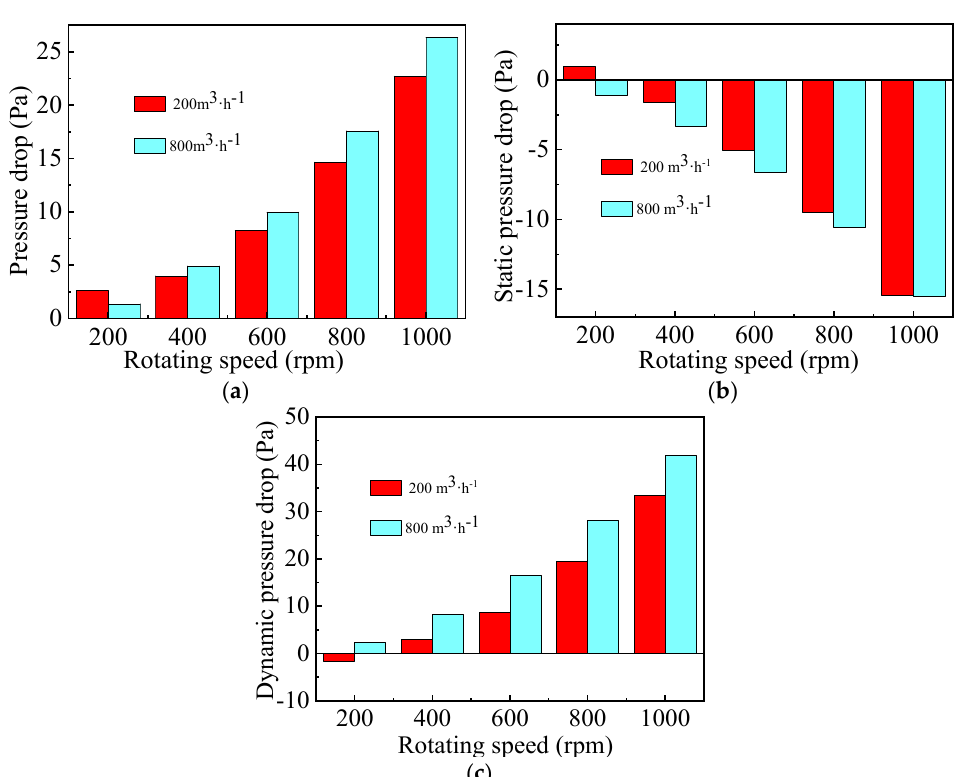
Figure 11. The effect of rotating speed on the pressure drop in the cavity zone B. ( a ) Pressure drop; ( b ) static pressure drop; ( c ) dynamic pressure drop.